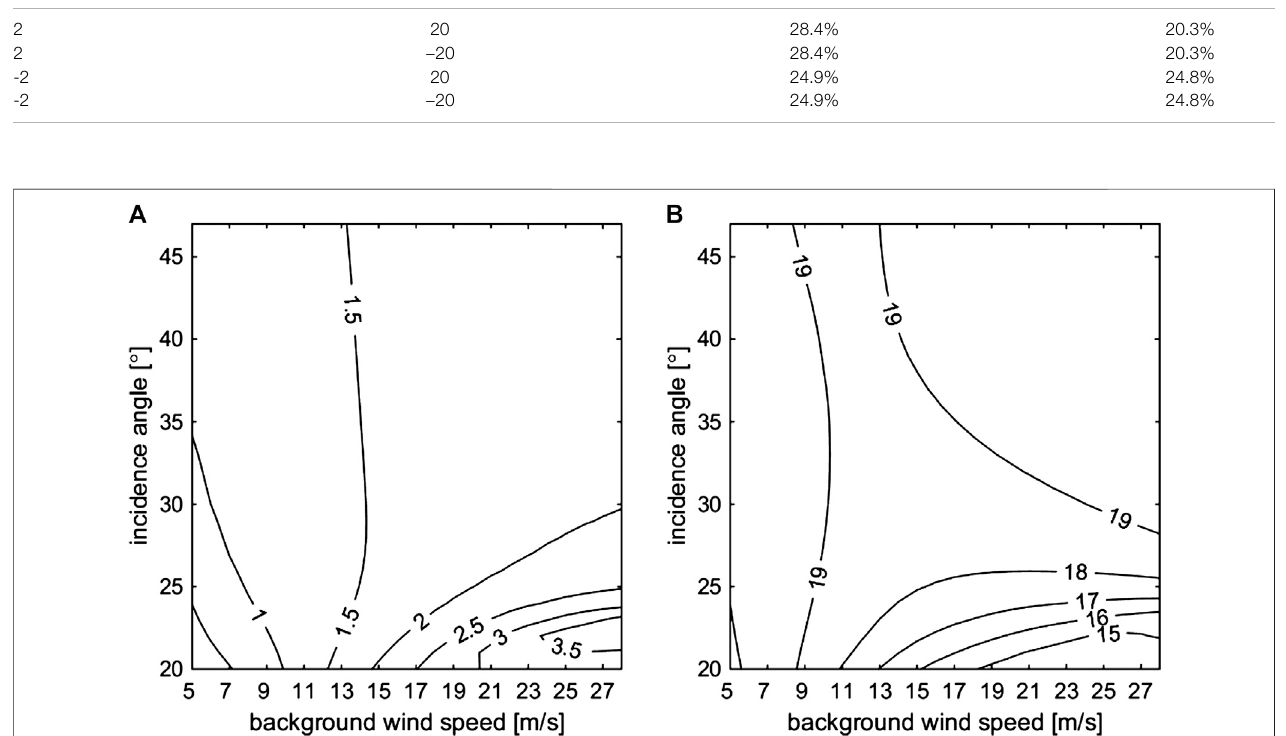
FIGURE 6 | OI-retrieved wind speed error (A) and direction error (B) when the incidence angle varies from 20 ° to 47 ° . Retrieval accuracy comparison of the OI, variational model inversion (VAR), and DIRECT methods.